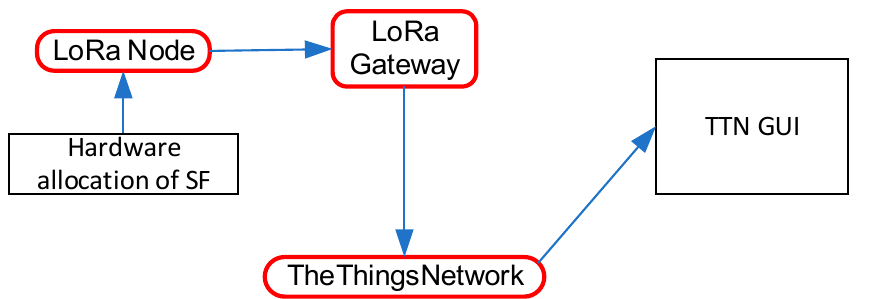
Figure 6. Communication architecture for the coverage estimation.